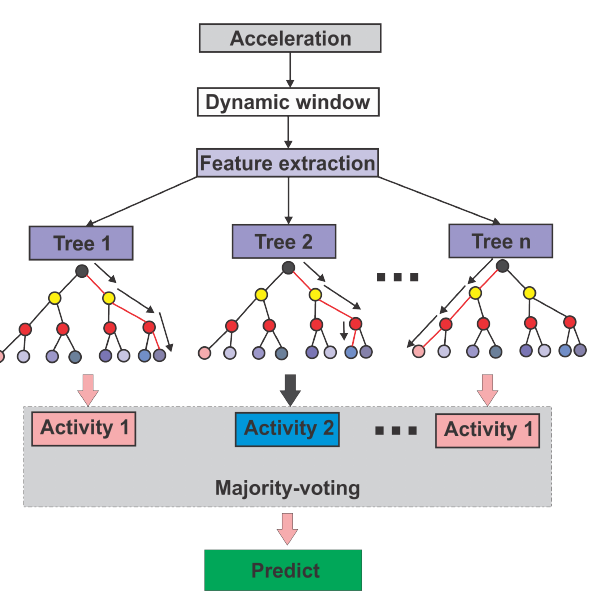
Fig 16. Random forest was implemented on the wearable.